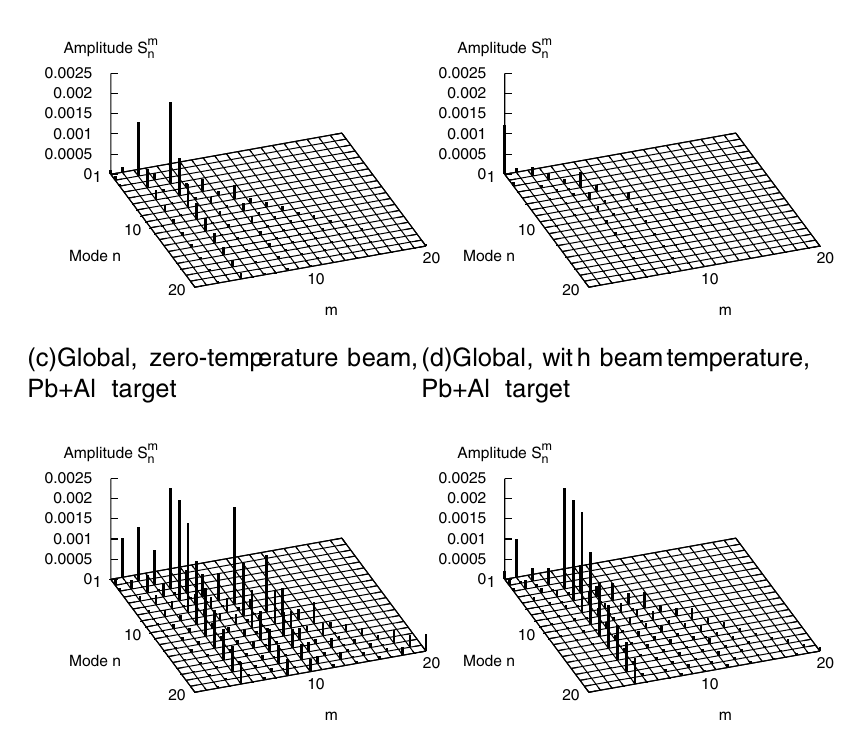
FIG. 8. The energy spectra at the Bragg peak layer (a) for the zero-temperature beam ( r (cid:6) 3 : 79 mm ) and (b) with the beam temperature ( r (cid:6) 3 : 87 mm ) for the Pb (cid:1) Al layer target. The global nonuniformity spectra using the weight w temperature beam and (d) with the beam temperature for the Pb (cid:1) Al layer target.